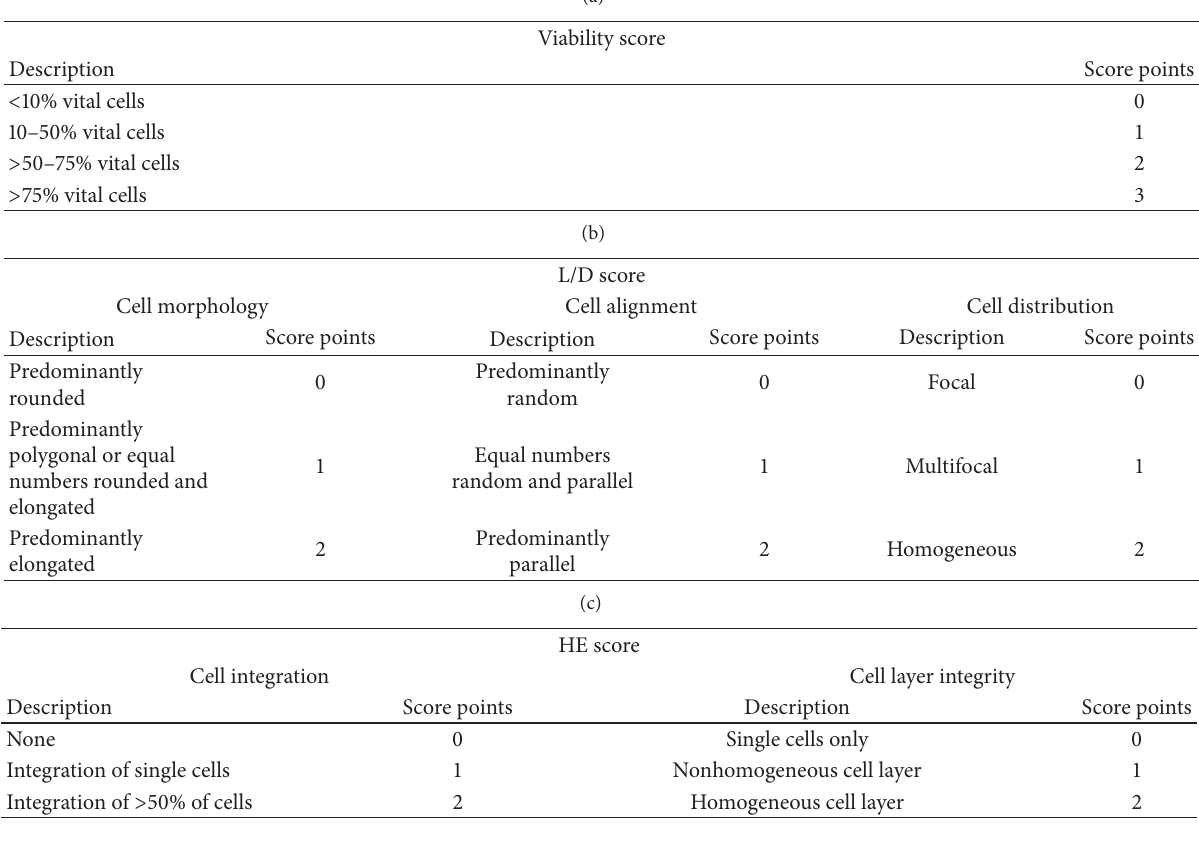
Table 1: Histology score systems. Score systems used for evaluation of LIVE/DEAD stained samples (viability score and L/D score) and hematoxylin and eosin stained sections (HE score).